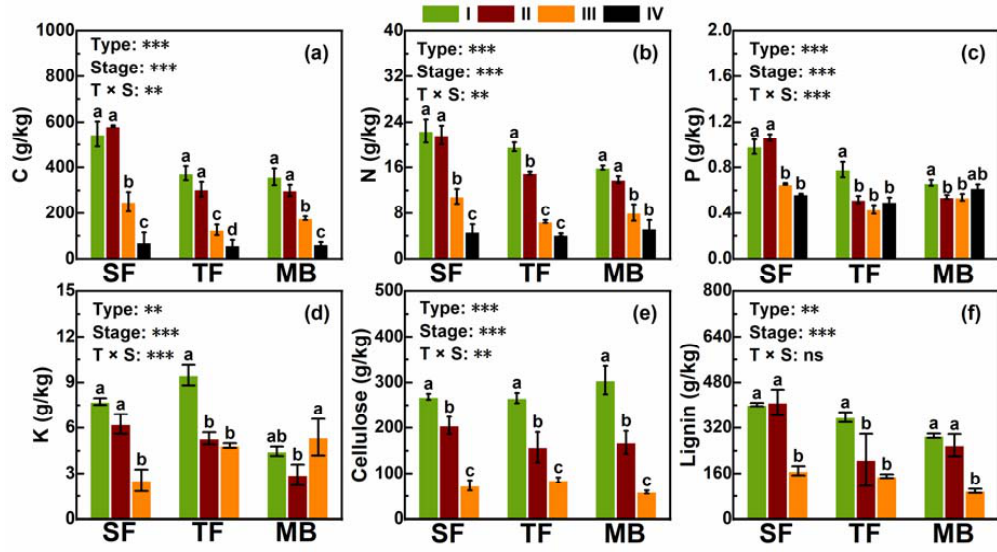
Figure 1. Concentrations of macro-elements, cellulose, and lignin at the four stages of litter decomposition (I, II, III and IV) in the three forest types. ( a – f ) a–e, in turn, is the concentration of C, N, P, K, Celllose, and Lignin in the litter and soil. SF—secondary broadleaved forest,